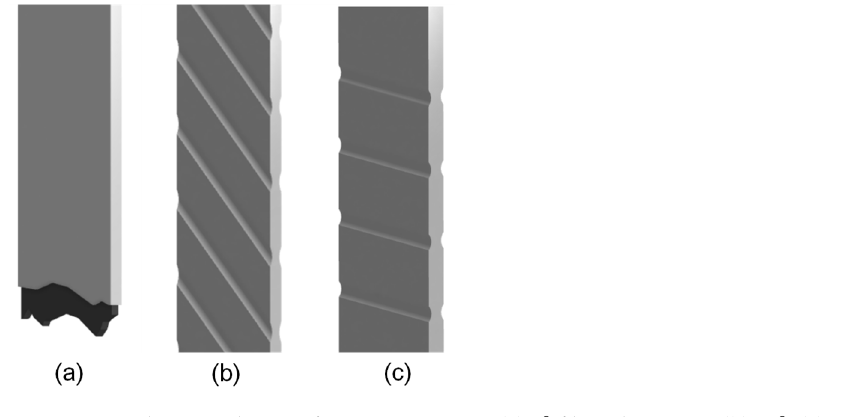
Figure 10. Failure topologies of AM Composites: ( a ) 0° fiber alignment, ( b ) 45°, ( c ) 90°.